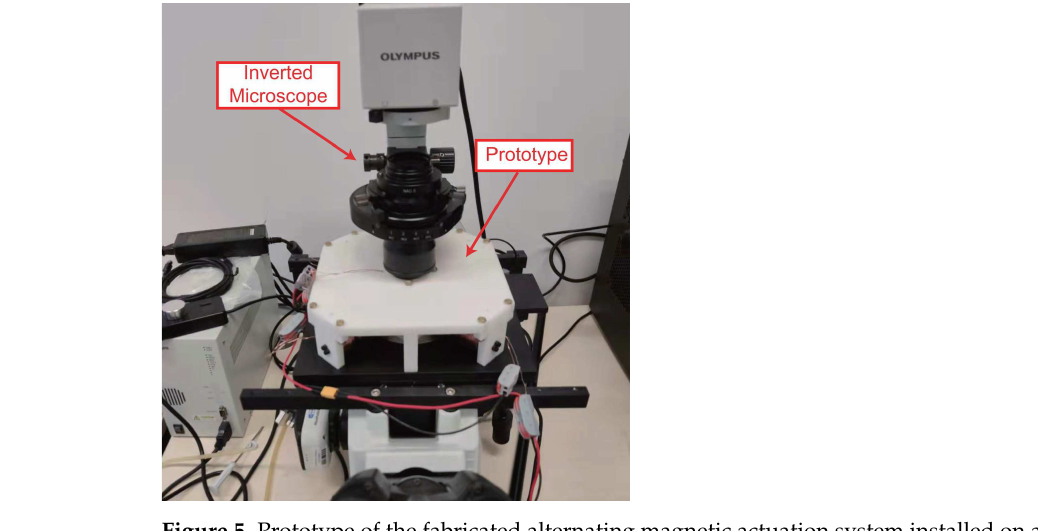
Figure 5. Prototype of the fabricated alternating magnetic actuation system installed on an inverted microscope.